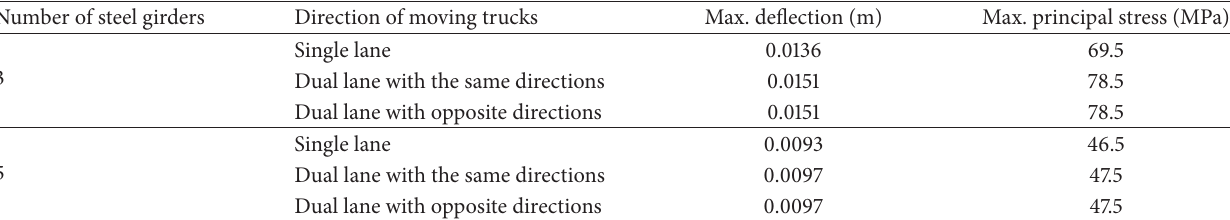
Table 4: Dynamic responses of unstrengthened composite